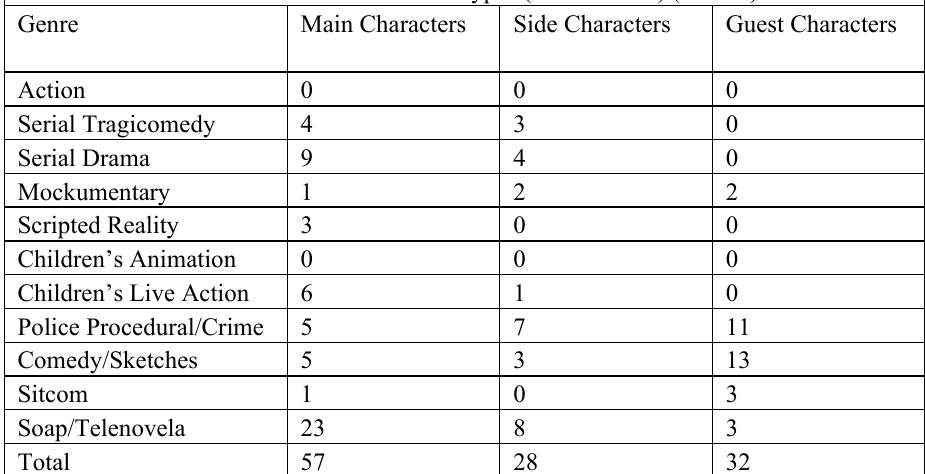
Table 4. Channel share of LGBT+ character types (2001 – 2016) (N=117)